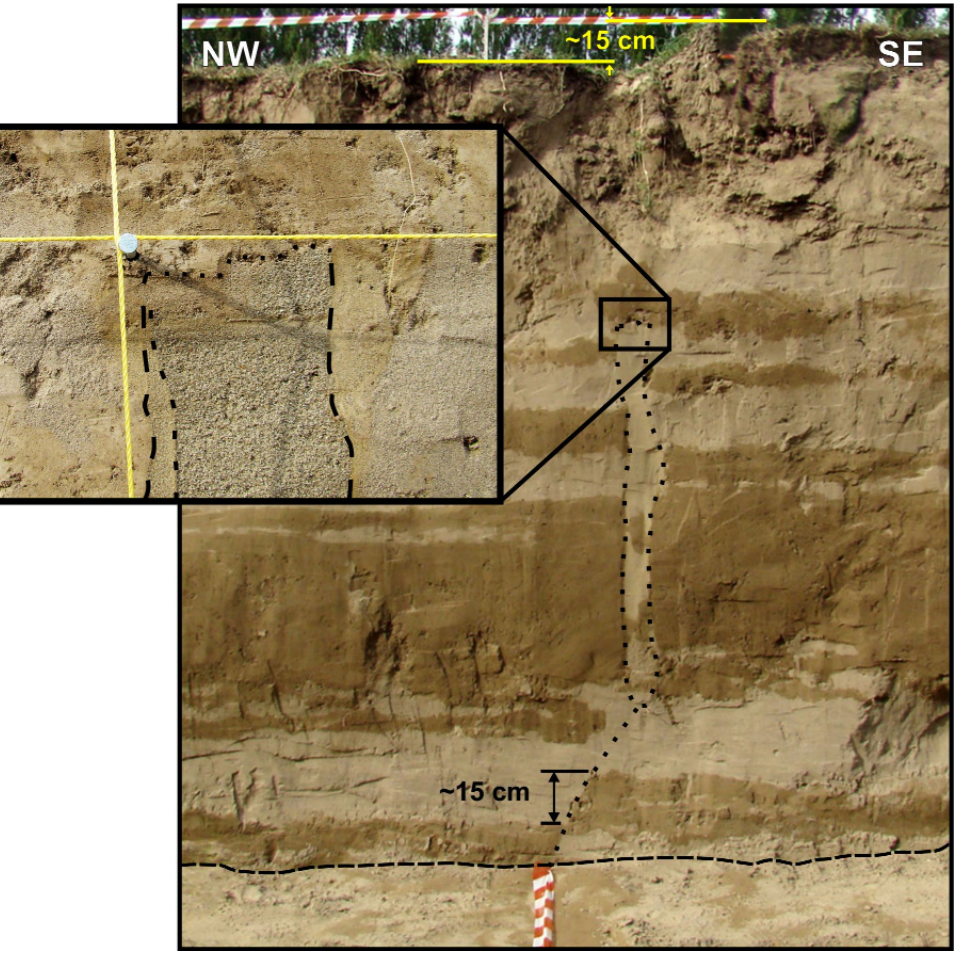
Figure 7. Example of a thick sand-filled dike (D3 on the northeastern wall) clearly sealed by younger sedimentary beds, thus emphasizing the occurrence of liquefaction events older than the May 2012 earthquake. See Figure 3 for location in the trench